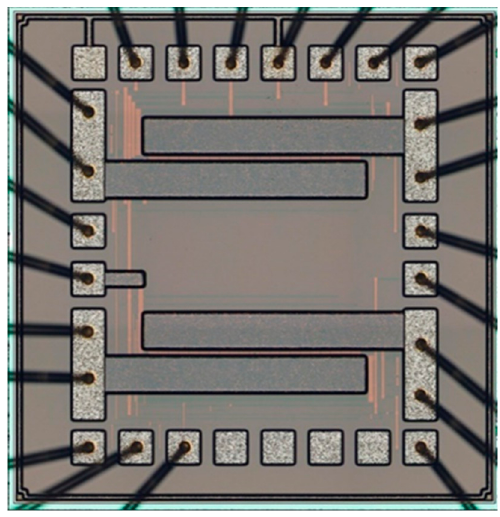
Figure 8. Picture of the test chip containing both structures: top—calibration structure, bottom—test